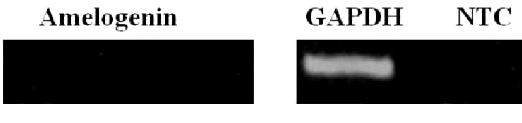
Figure 6. Absence of amelogenin expression in HERS cells. The expression level of amelogenin gene was normalized to the corresponding GAPDH endogenous